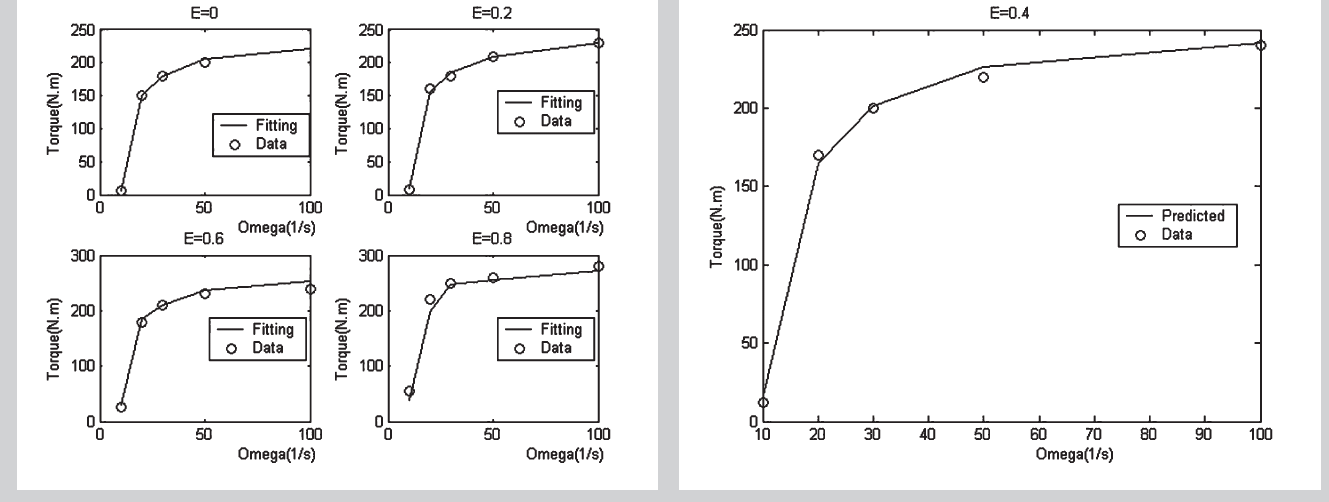
Figure 2 (left): Comparison between the torques calculated by employing our discovered function given in Eq. 2 and the corresponding experi- mental points of eccentrici- ties of 0, 0.2, 0.6, and 0.8. Figure 3: Comparison between the experimental and predicted torques versus angular velocity, W , at eccentricity